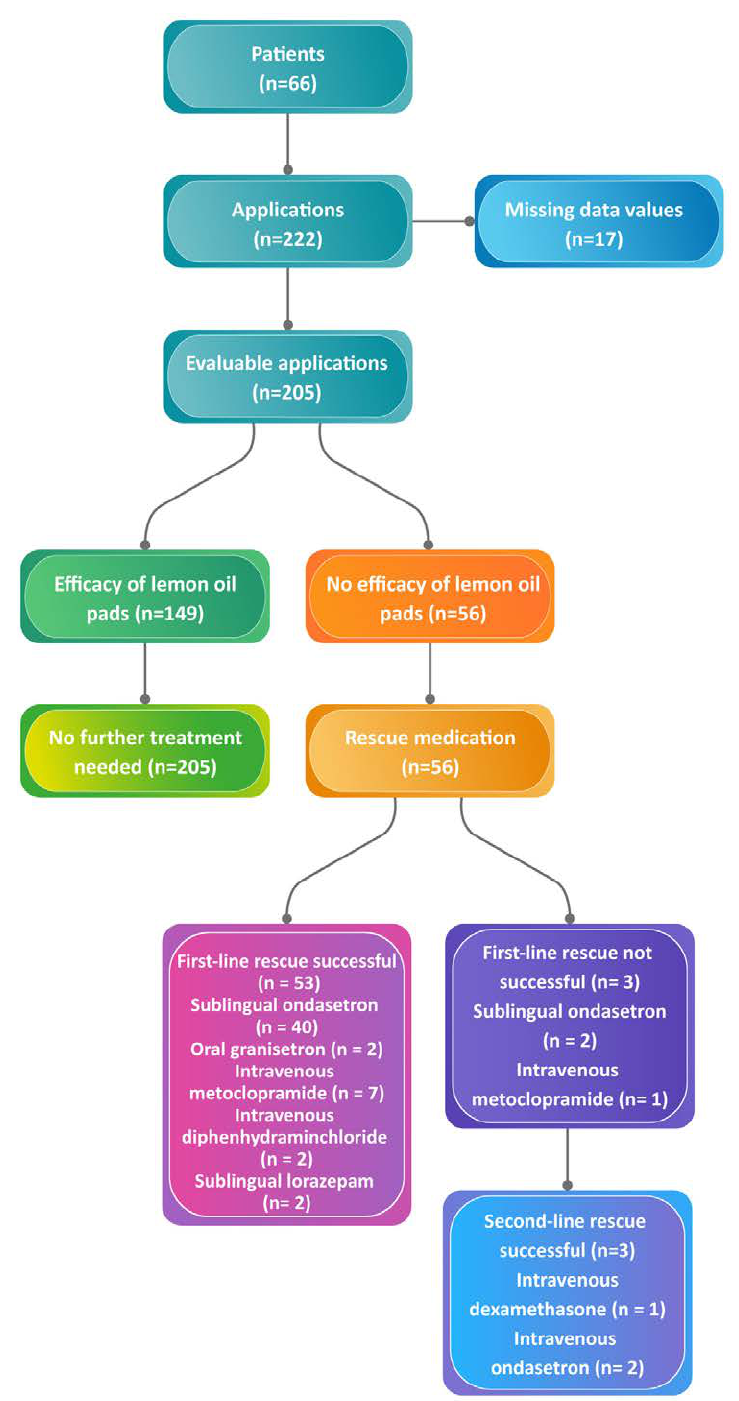
Figure 1. Efficacy of aromatherapy applications (lemon oil pads) against nausea/vomiting. Sixty-six patients received a total of 222 aromatherapy applications. Data were missing from 17 applications. Two hundred five applications were evaluated. Lemon oil pads were efficient in 149 applications, and no further rescue medication was needed. No efficacy of lemon oil pads was seen for 56 applications. First-line rescue medication was successful in 53 applications. Second-line rescue medication was successful in the remaining 3 applications. There were 17 patients with breast cancer (25.8%), 15 with lung cancer (22.7%), 13 with colorectal cancer (19.7%), 9 with ovarian cancer (13.6%), 5 with head and neck cancer